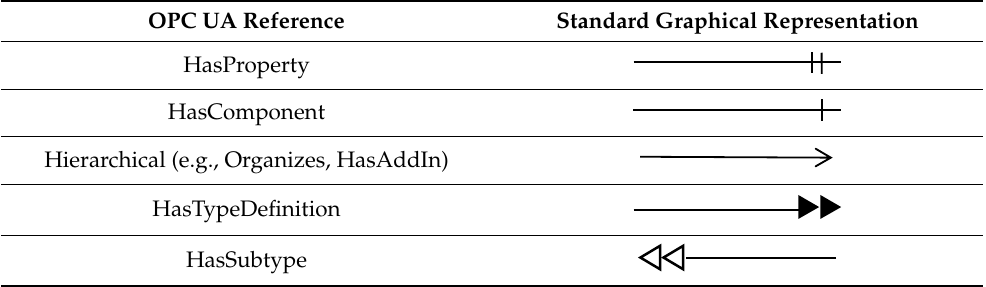
Table 2. Graphical representation of some OPC UA References.